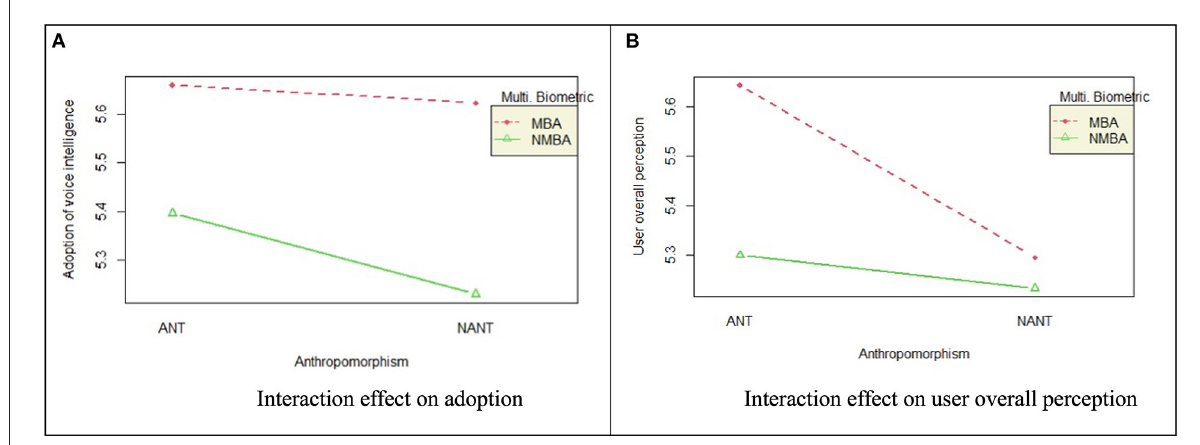
FIGURE2 Interaction effects. (A) Examining the effect of anthropomorphism and multimodal biometric authentication on the customer’s willingness to adopt voice technology in their value chain. (B) Examining the effect of anthropomorphism and multimodal biometric authentication on the overall customer perception of voice technology in